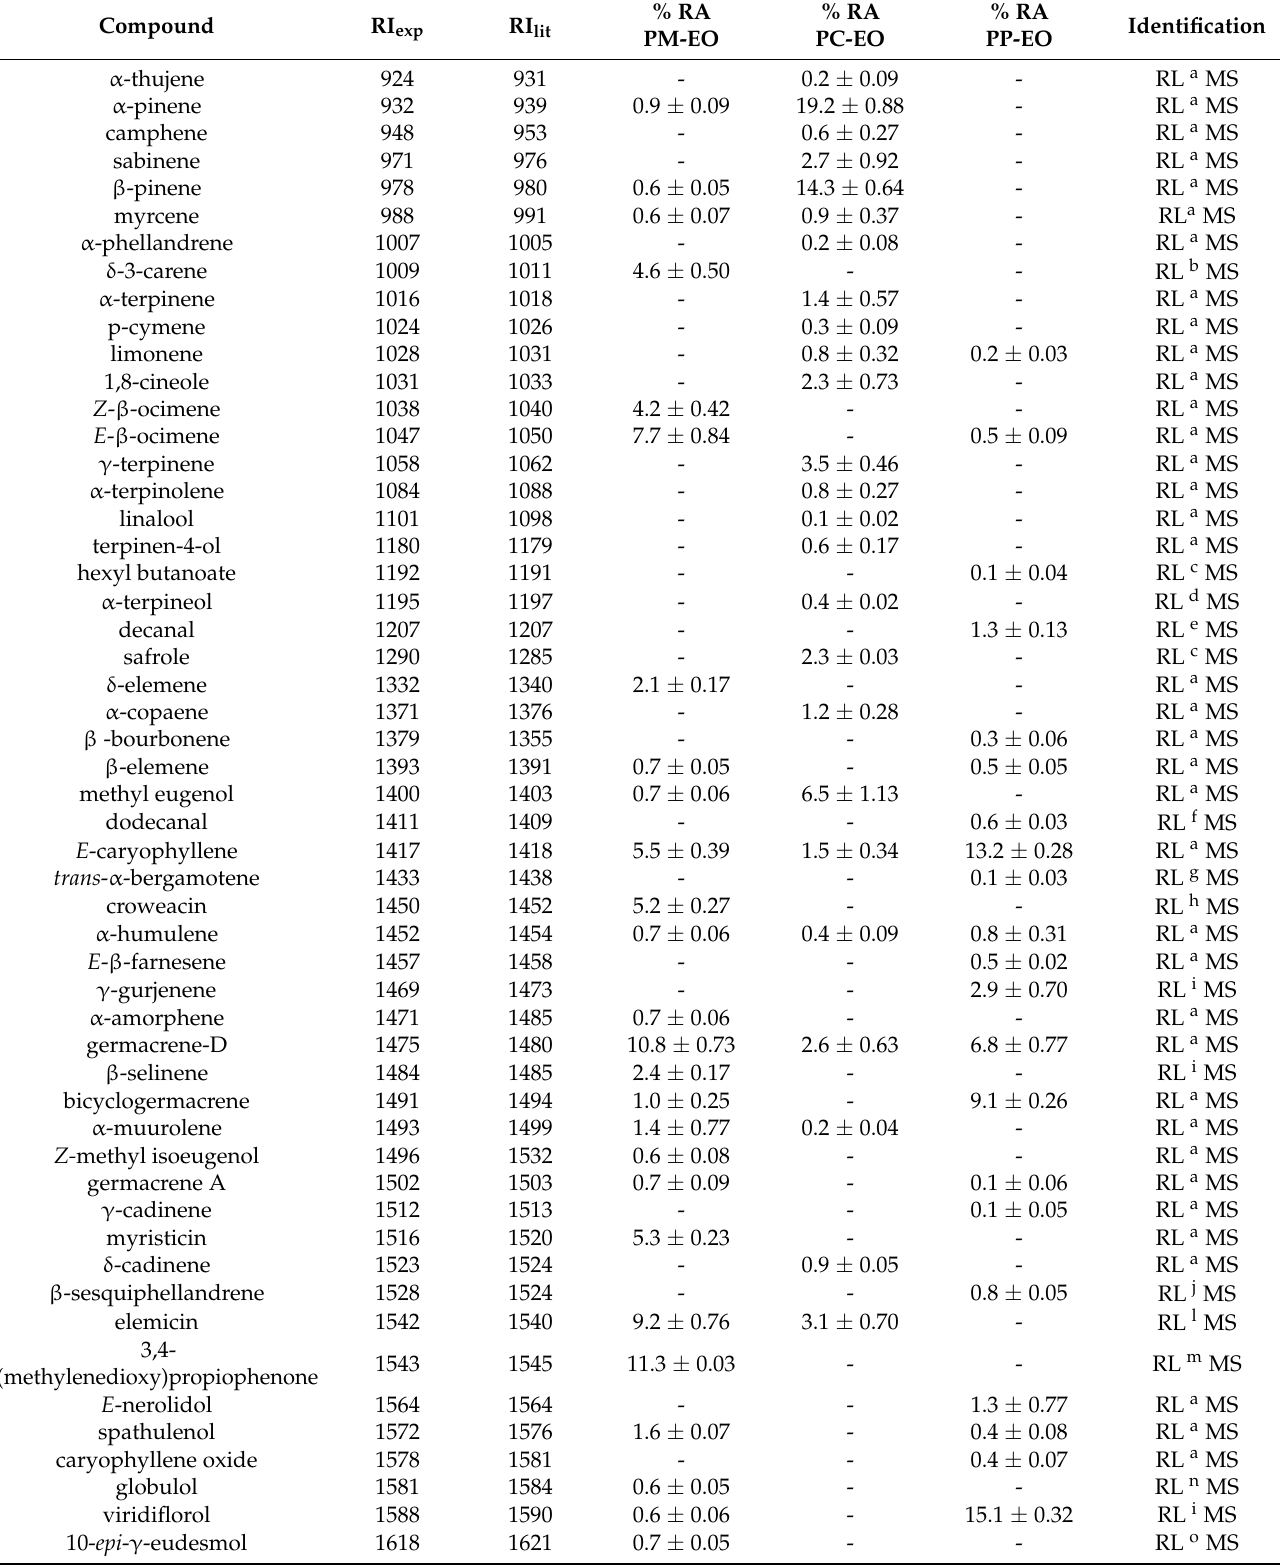
Table 1. Chemical compounds detected in the EOs extracted from Piper callosum (PC-EO), Piper marginatum (PM-EO), and Peperomia pellucida (PP-EO). The compounds were quantified by GC-FID and identified by